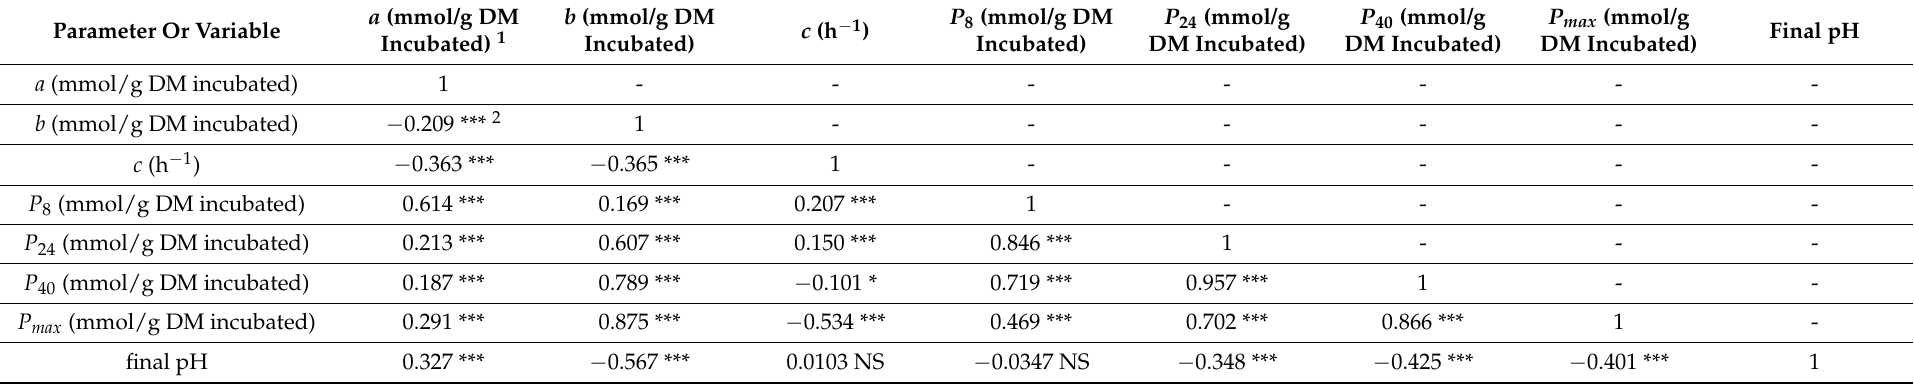
Table 3. Pearson correlation coefficients r between gas production parameters and final pH of rumen in vitro incubations of straw from oats and wheat genotypes from three breeding trials (Oats 1, advanced breeding lines and commercial varieties; Oats 2, commercial and historical varieties; Wheat, advanced breeding lines and commercial varieties).